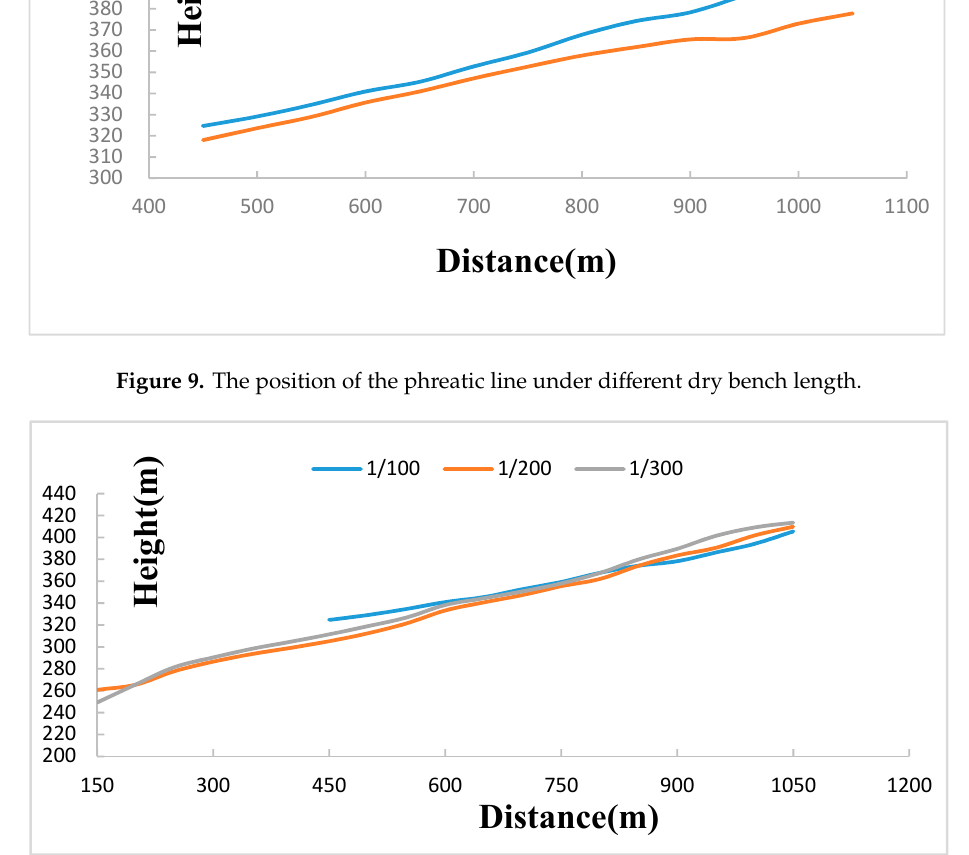
Figure 10. The position of phreatic line under different upstream slope ratios.